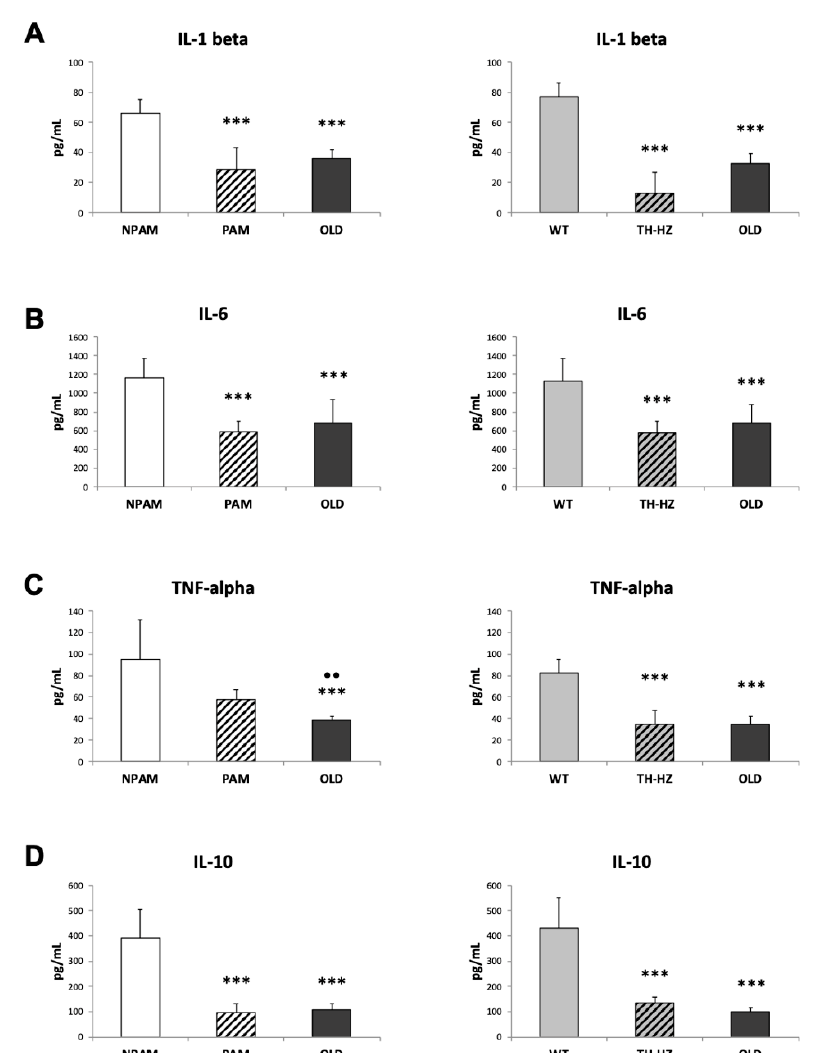
Figure 6. Pro ‐ inflammatory and anti ‐ inflammatory cytokines (pg/ml) released by peritoneal leukocytes incubated in presence of the mitogen ConA. IL ‐ 1 β ( A ); IL ‐ 6 ( B ); TNF ‐α ( C ); IL ‐ 10 ( D ) released by cells from adult PAM, NPAM, TH ‐ HZ, WT mice, and chronologically old animals. PAM: prematurely aging mice, NPAM: non ‐ prematurely aging mice, TH ‐ HZ: tyrosine hydroxylase hemi ‐ zygotic mice, WT wild ‐ type mice. Each column is the mean ± SD of the values of 10 experiments corresponding to 10 animals. * p < 0.05, *** p < 0.001 with respect to the corresponding controls. ∙∙ p < 0.01 with respect to PAM.